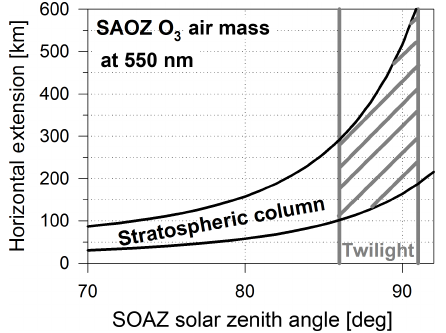
Figure 4. Estimated horizontal extension of the ozone air mass probed by the zenith-sky UV–VIS spectrometer from 70 to 92 ◦ SZA (calculation based on SAOZ settings in the Chappuis band at 550nm). The shaded area shows the air mass extension during the twilight period. Reproduced from Lambert and Vandenbussche